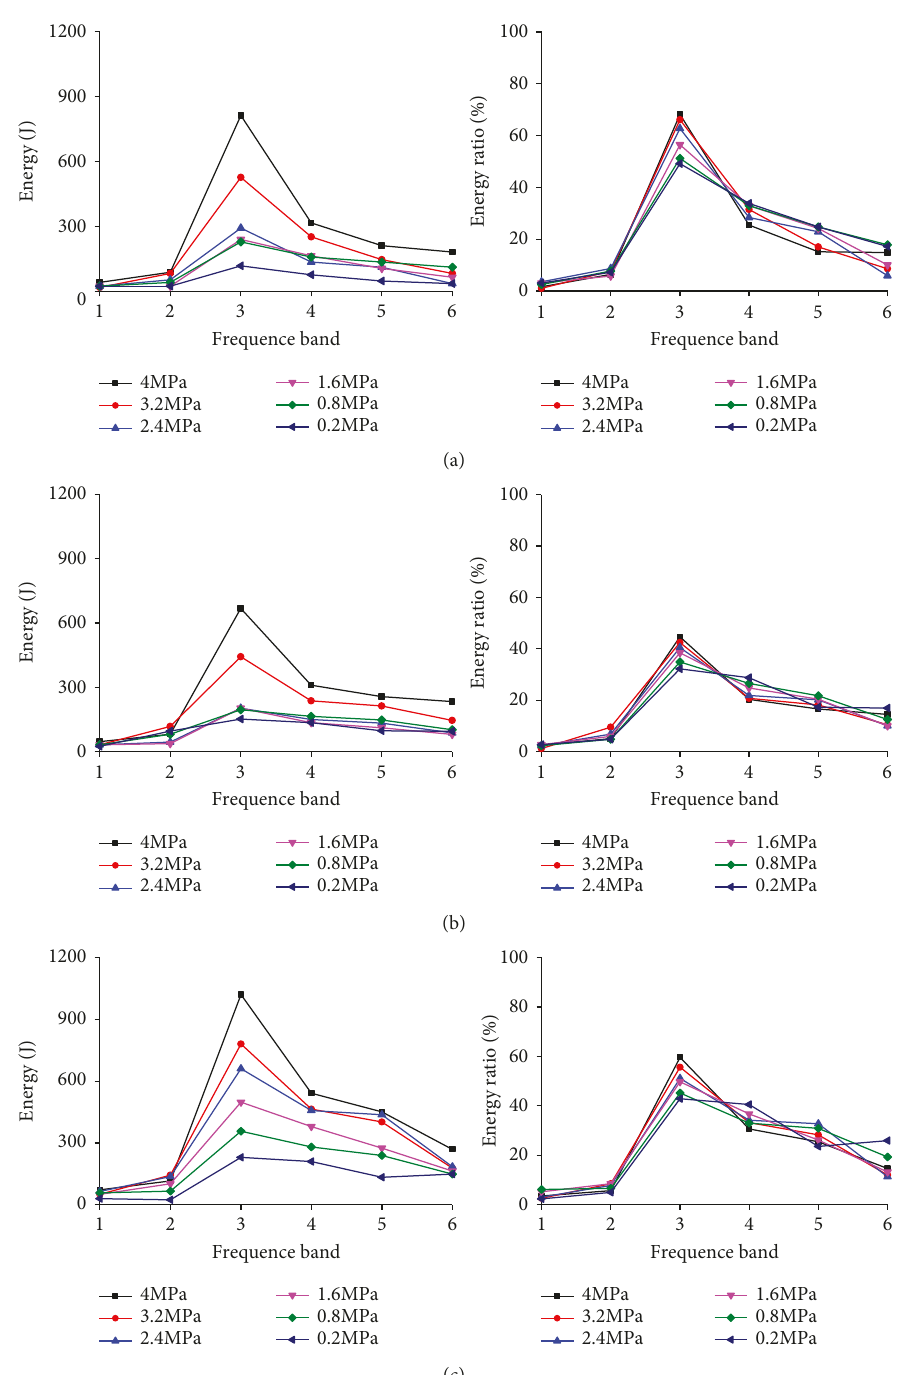
Figure 15: Energies and energy ratios in frequency bands of response signals under different confining pressures (vibration intensity of 3). (a) Intact model. (b) Damage model. (c) Failure